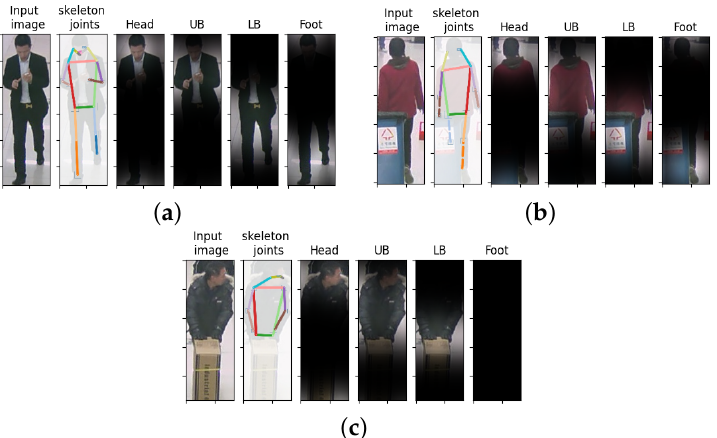
Figure 3. The pedestrian image with soft attention masks corresponding to attention masks in different classes where ( a ) all joints can be localized, ( b ) some joints can be detected from the partial occlusion, and ( c ) there is full occlusion.